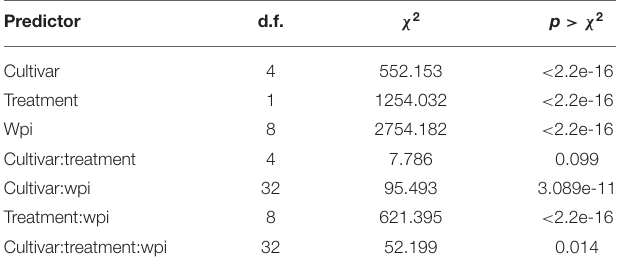
TABLE 1 | Analysis of deviance results for the generalized linear model for the proportion of symptomatic leaves of explants in the in vitro study. Predictor